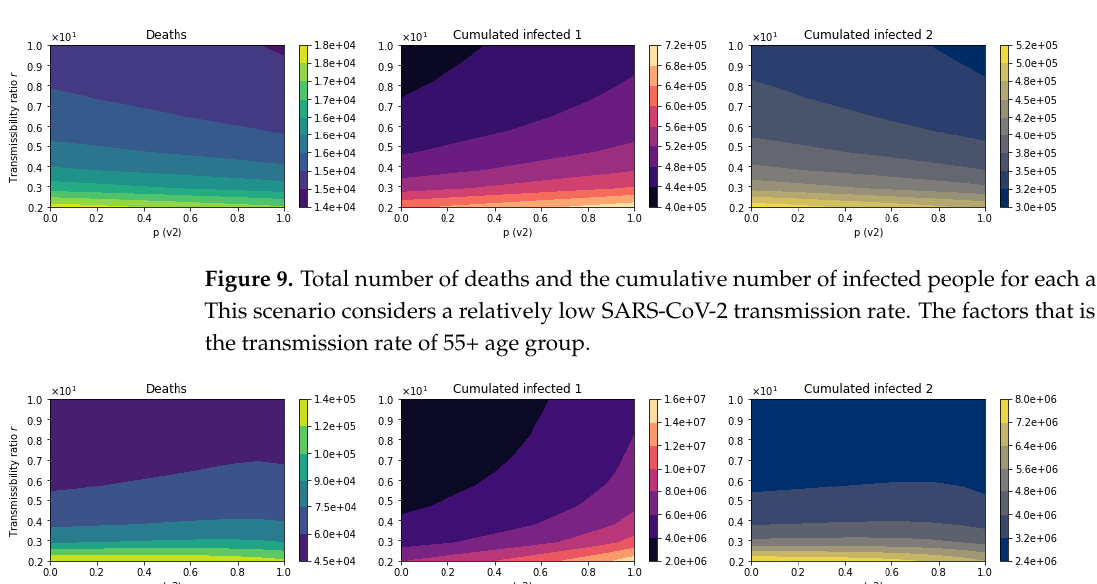
Figure 10. Total number of deaths and the cumulative number of infected people for each age group. This scenario considers a relatively high SARS-CoV-2 transmission rate. The factor that is varied is the transmission rate of 55+ age